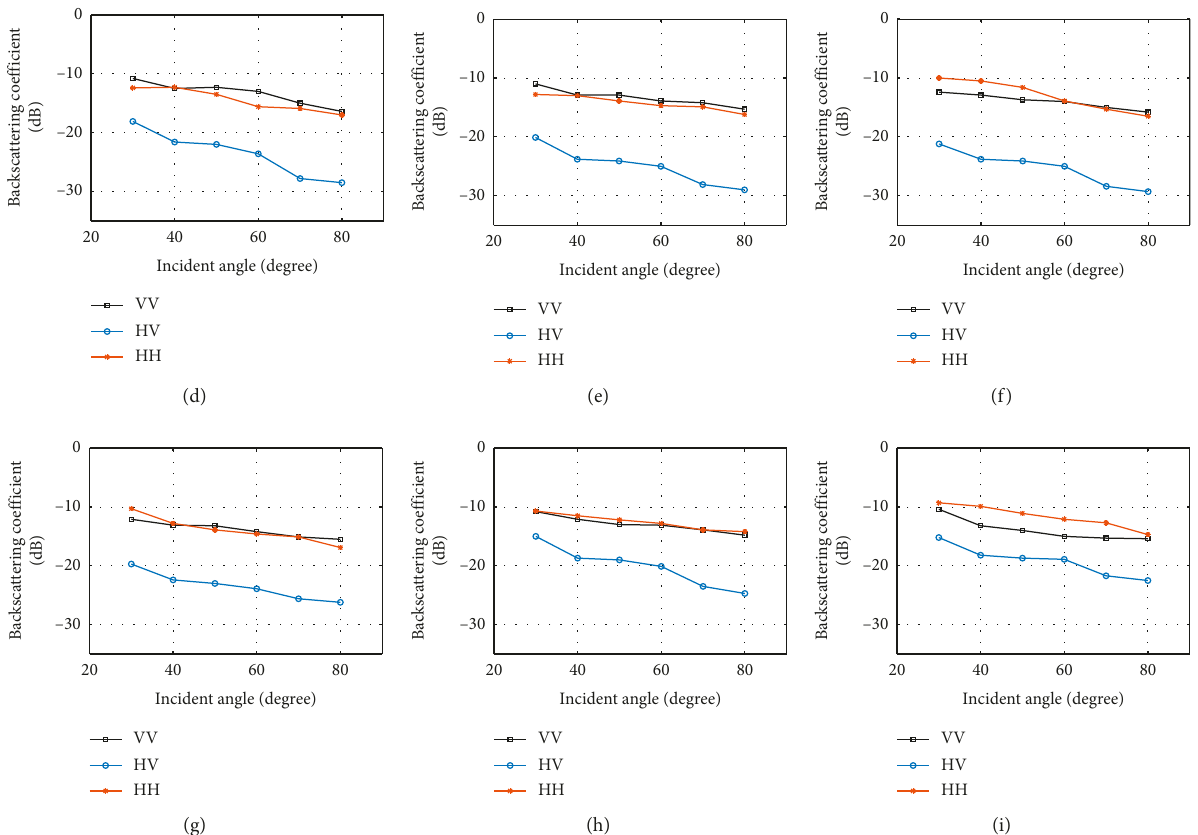
Figure 10: The angular responses of the backscattering coefficient for the pine tree in (a) 28 GHz, (b) 29GHz, (c) 30 GHz, (d) 31 GHz, (e) 32GHz, (f) 33GHz, (g) 34GHz, (h) 35GHz, and (i) 36GHz.